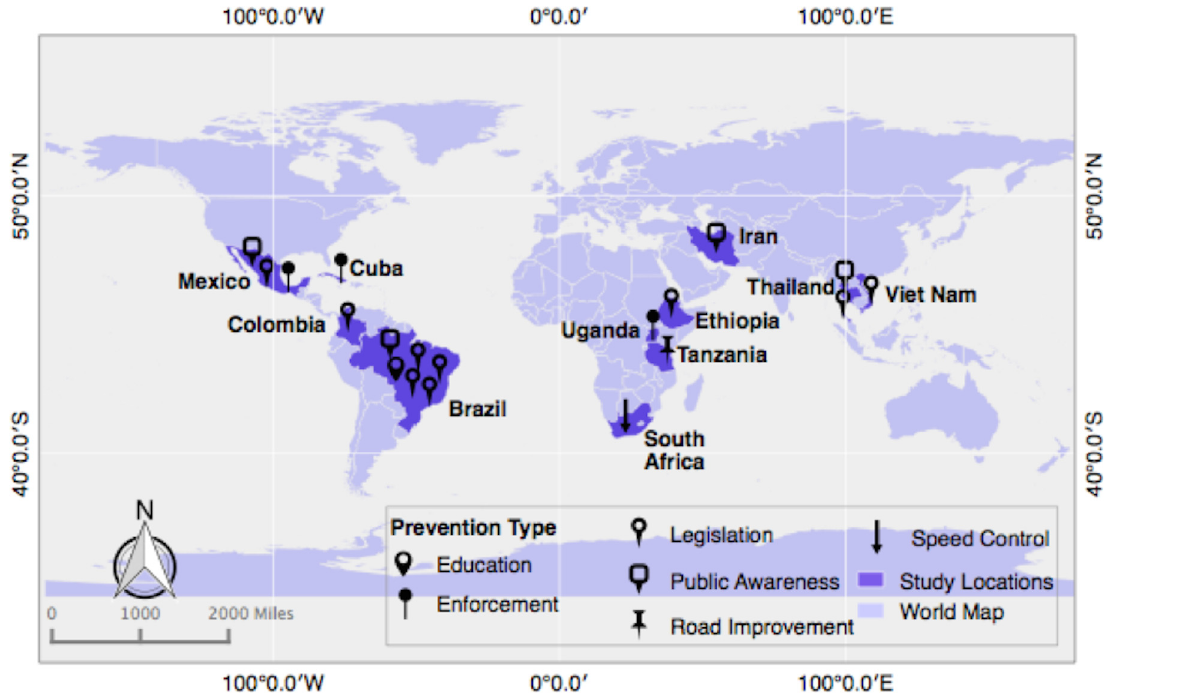
Fig 2. Map of the location and type of intervention evaluations